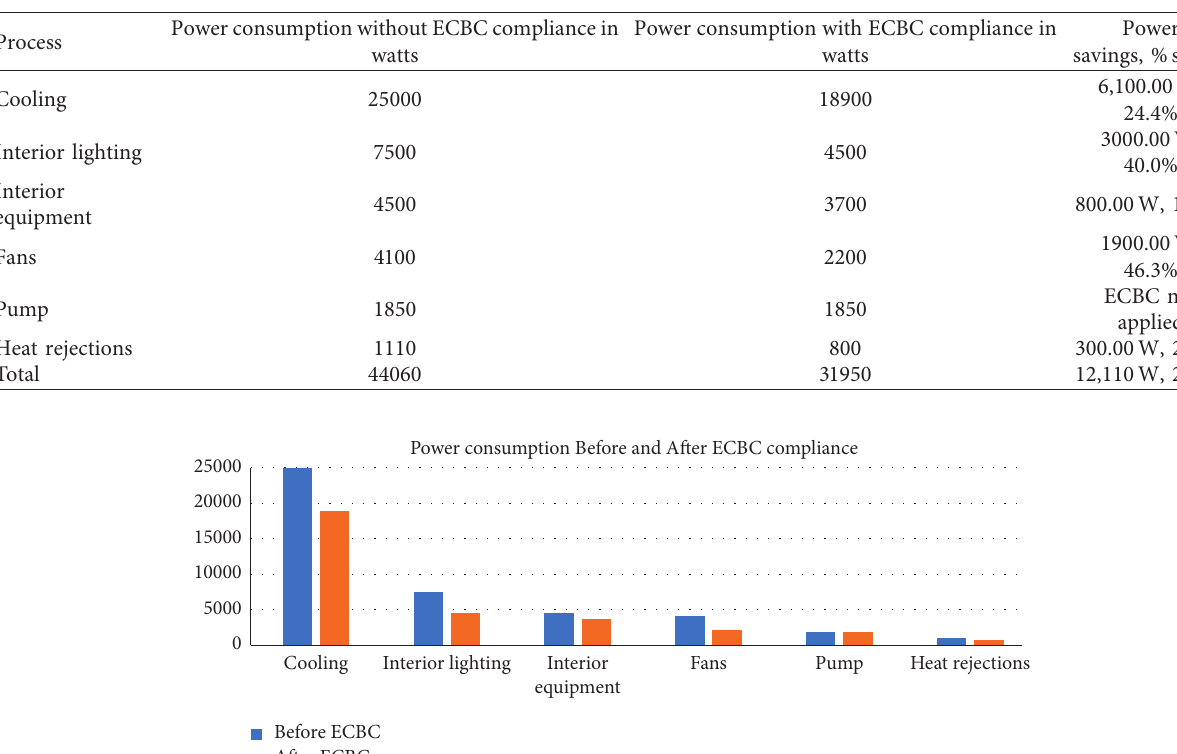
Table 3: Comparison of power consumed by various loads without and with ECBC compliance.